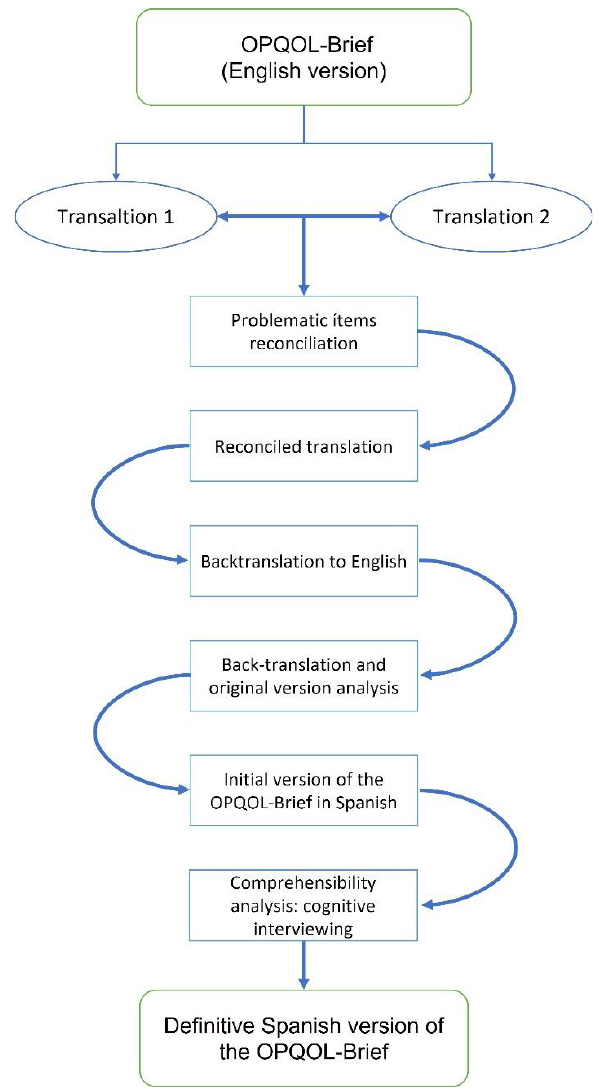
Figure 1. Translation and cultural adaptation process.